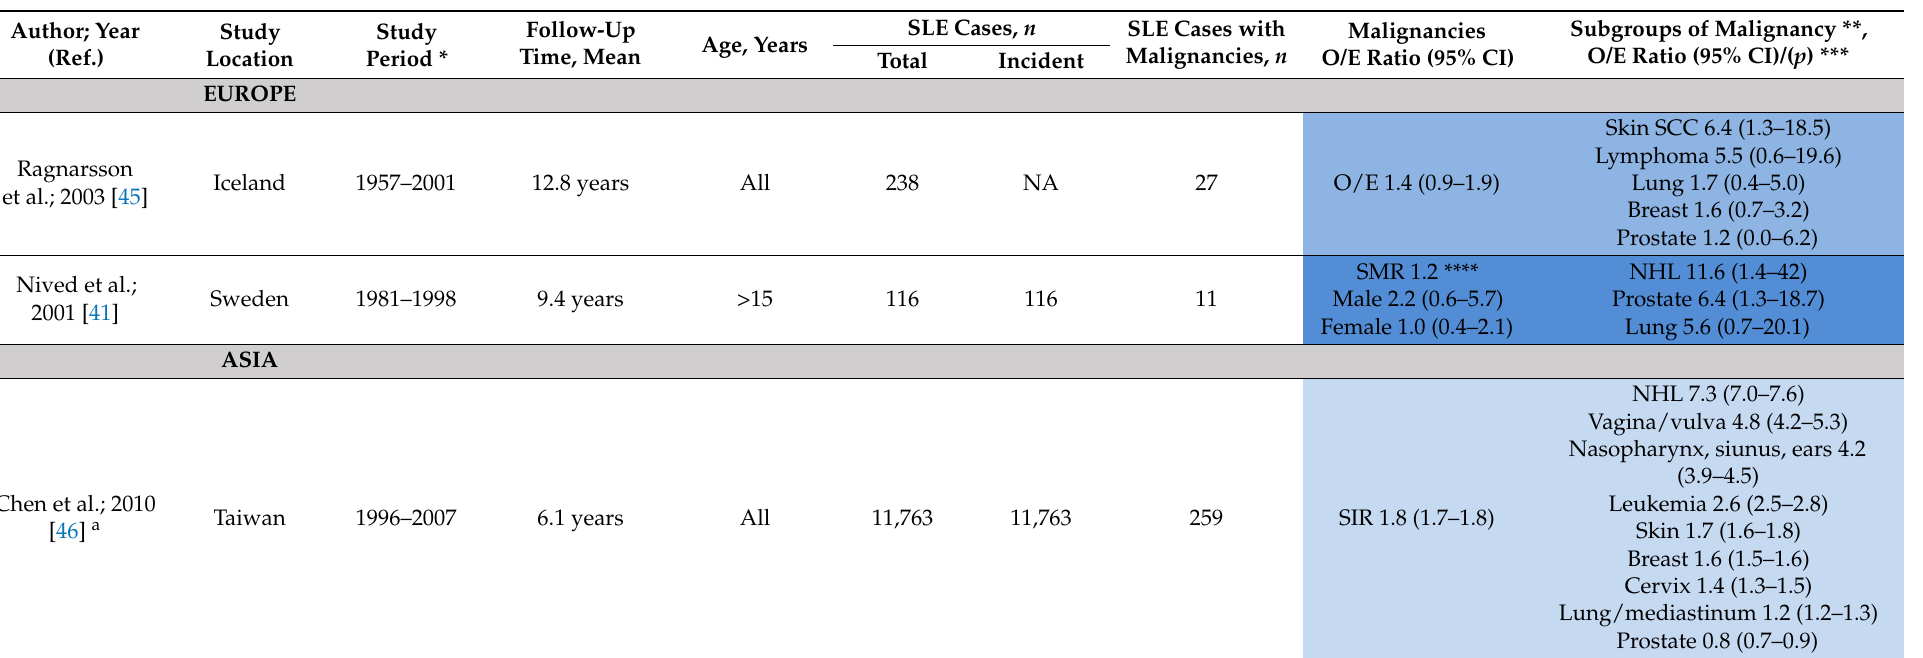
Table 3. Cancer risk in Systemic Lupus Erythematosus relative to the general population, from population-based